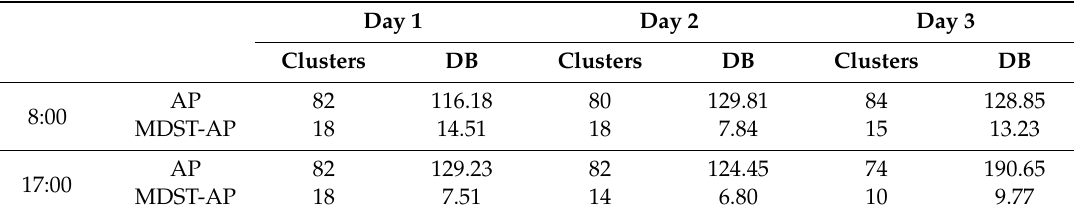
Table 4. Comparison of algorithms.